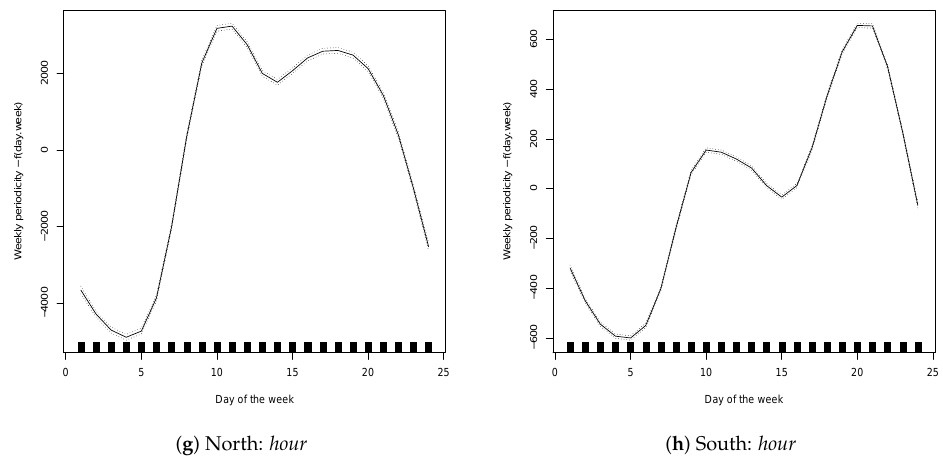
Figure 8. in-sample estimation results of the non-parametric additive model for the conditional mean of electricity demand. For both zones, each panel plots estimated function f j ( · ) for the calendar effects and the overall trend. Moreover, the effect of Bank ” leads to a demand reduction of about 1230 MWh for the norhtern zone and about 400 MWh for the southern zone.